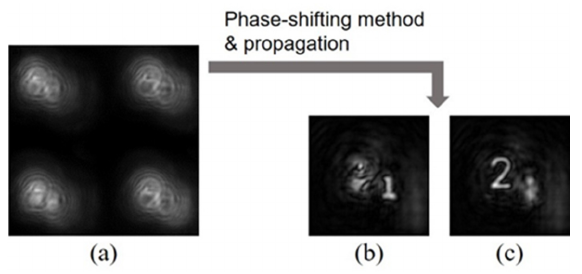
Figure 3. Proof-of-principle experimental results. ( a ) Captured raw image. ( b , c ) Reconstructed im- ages through a phase-shifting method and numerical propagation based on an angular spectrum method.